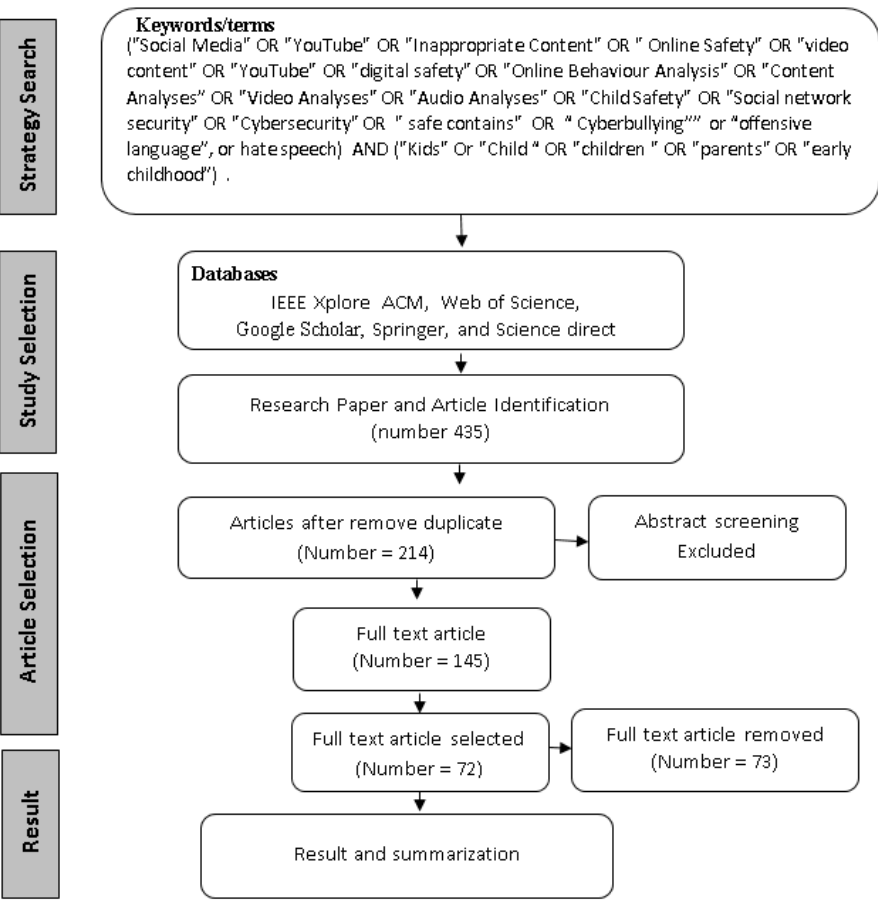
Figure 1. SR methodology framework.